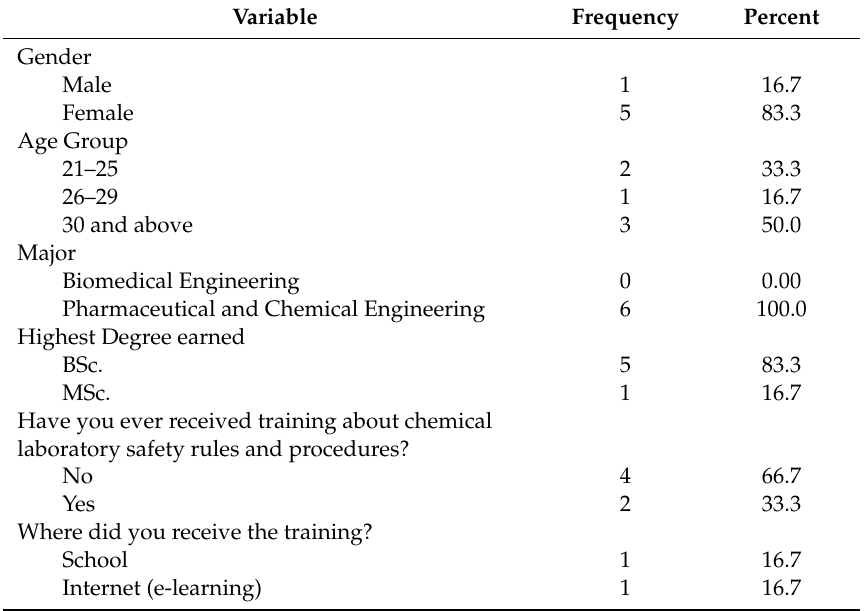
Table 5. Frequency distribution of supervisors by selected demographics.